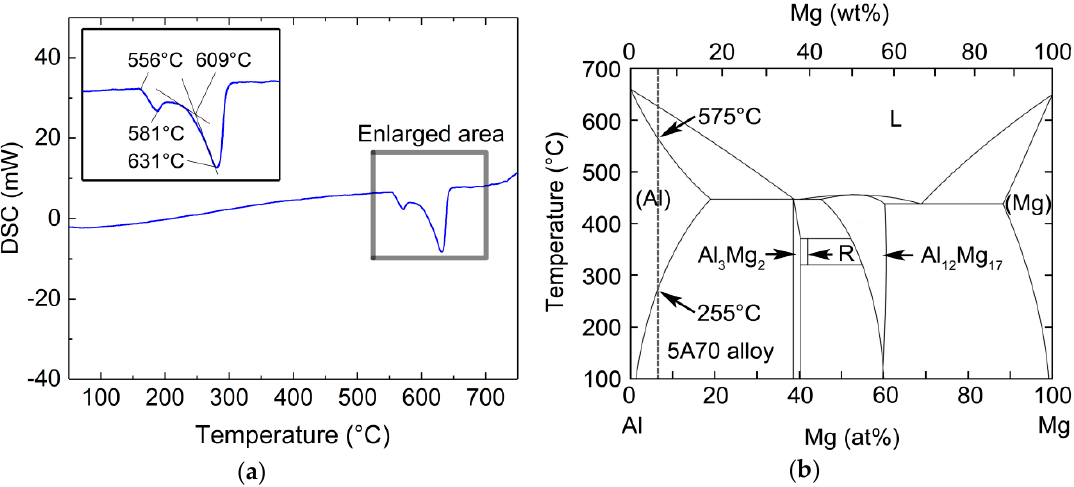
Figure 1. Differential scanning calorimeter (DSC) results of the 2 mm thick fine-grained 5A70 alloy ( a ) and the binary Al-Mg phase diagram ( b ).